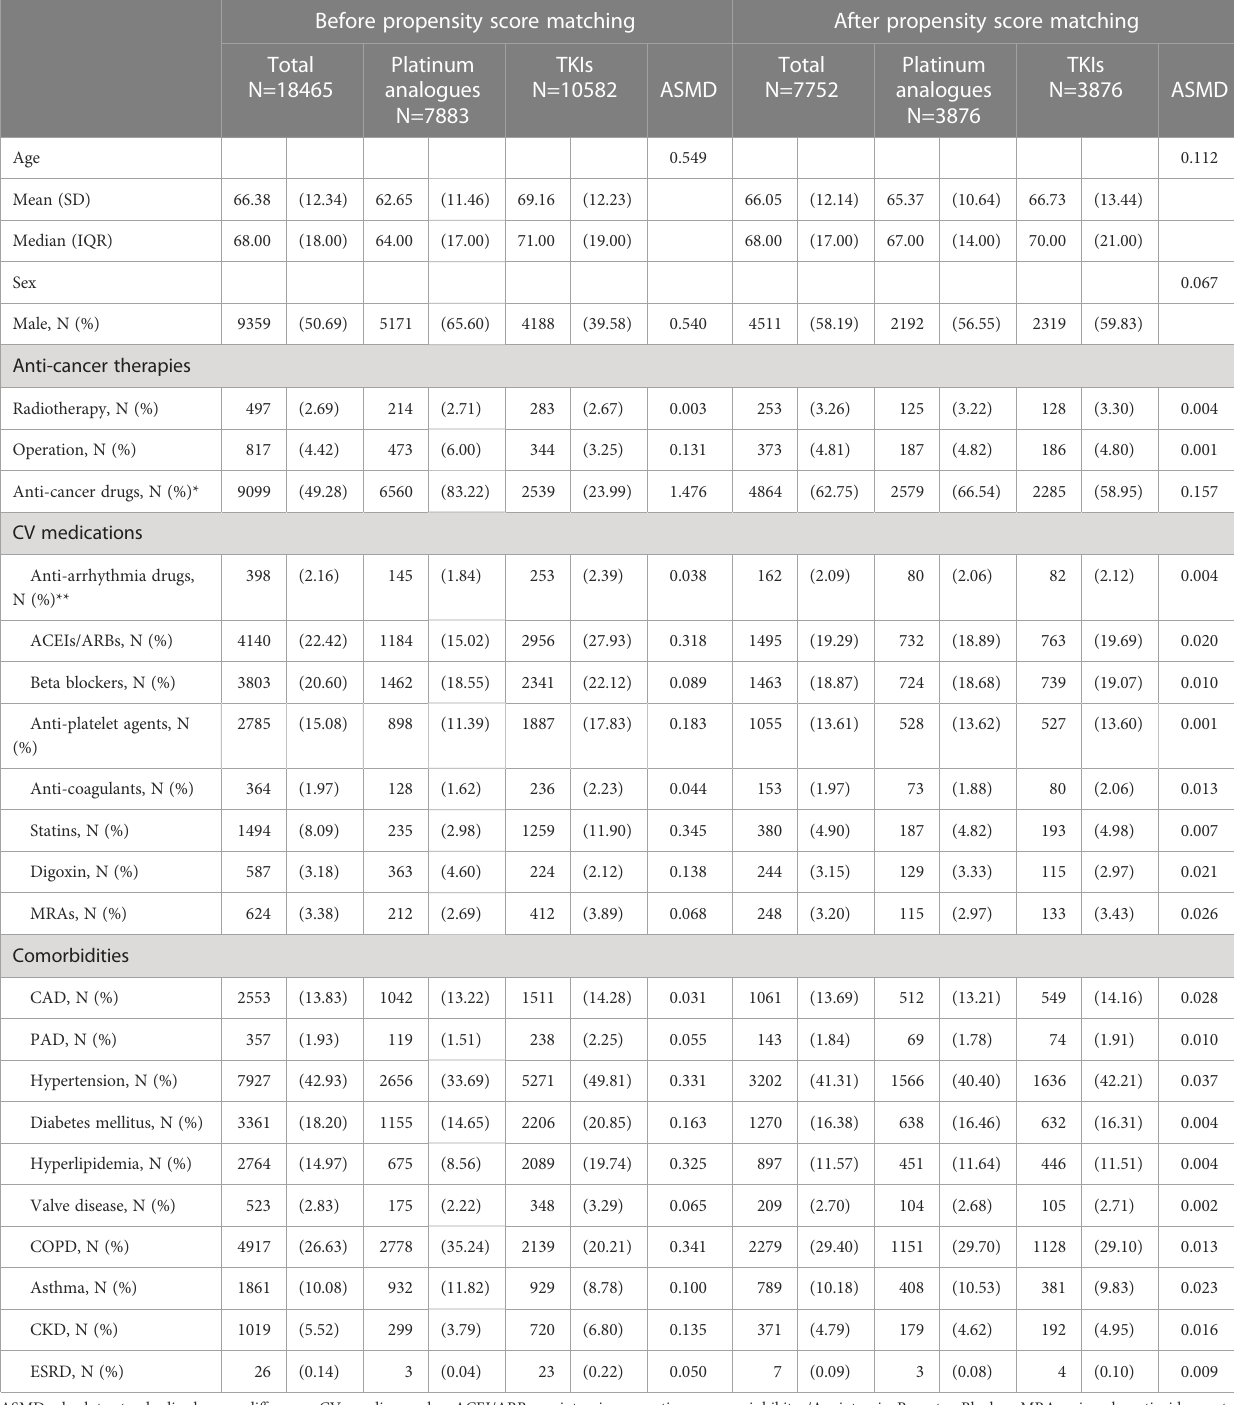
TABLE 1 The baseline characteristics of patients with non-small cell lung cancer (NSCLC) treated with either Platinum analogues or TKIs before and after propensity score matching. Before propensity score